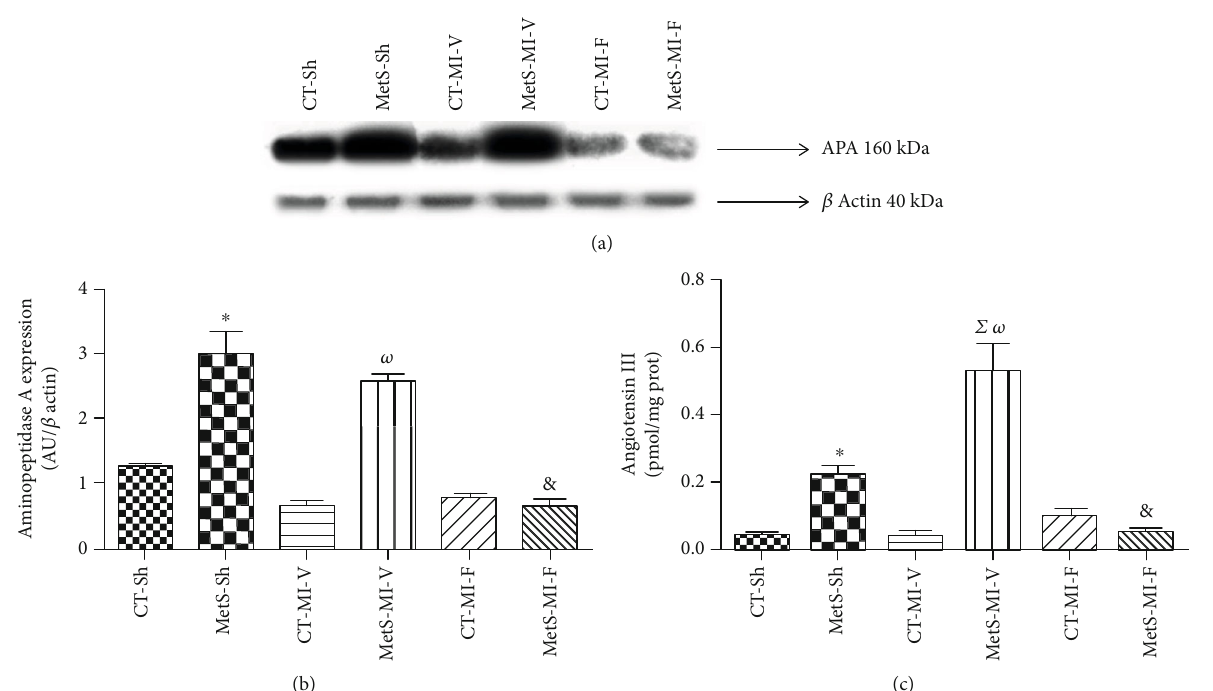
Figure 4: E ff ect of feno fi brate on the expression of aminopeptidase A (APA) and angiotensin III (Ang III) concentrations in the control (CT) and metabolic syndrome (MetS) rats under ischemic conditions (MI). (a) Representative western blot analysis. (b) APA protein expression. (c) Ang III concentration. Arbitrary units (AU). The values show the mean ± SEM ( n = 5 per group). ∗ p < 0 : 05 vs. CT-Sh; Σ p < 0 : 05 vs. MetS- Sh; ω p < 0 : 05 vs. CT-MI-V; & p < 0 : 05 vs. MetS-MI-V. Analysis of